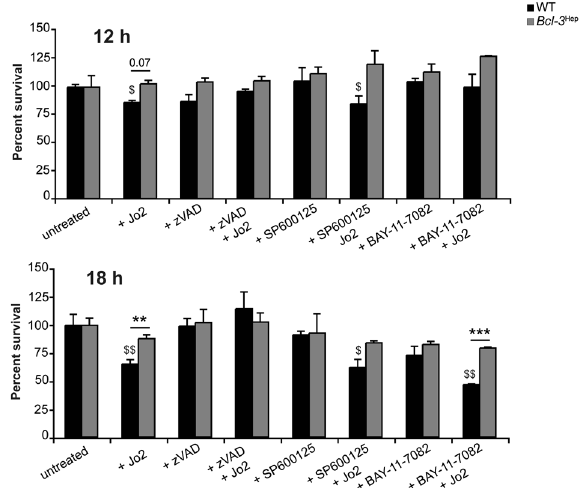
Fig. 7 Rate of Jo2-induced hepatocyte cell death in vitro. Primary Bcl-3 Hep and WT hepatocytes were treated ex vivo with Jo2 (50 ng/mL). Pan caspase inhibitor zVAD (50 µM), JNK inhibitor SP600125 (100 µM), or IKK inhibitor BAY-11-7082 (10 µM), where ever indicated, were added 1 h before Jo2-treatment. After 12 and 18 h cell survival was assessed by MTT assay. Untreated hepatocytes were used as baseline controls. Numerical data in mean ± SEM of two independent experiments performed at least in duplicate readings. ** p < 0.01, *** p < 0.001 for WT vs. Bcl-3 Hep and $ p < 0.05, $$ p < 0.01 for untreated vs. treated hepatocytes according to an unpaired, two-tailed Student ’ s t